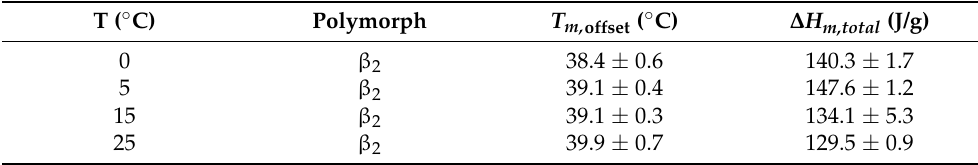
Table 5. The offset temperature of melting and total melting enthalpy obtained with DSC of tempered cocoa butter kept at several temperatures. The polymorphic type was obtained from XRD-data.